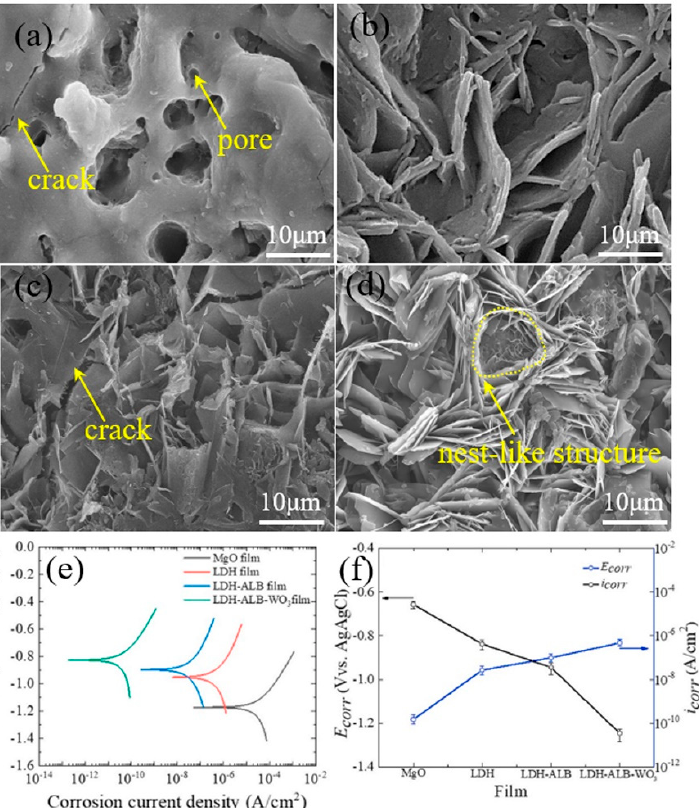
Figure 7. ( a – d ) SEM images showing the surface morphologies of MgO, LDH, LDH–ALB (albumin), and LDH–ALB–WO 3 films, respectively. ( e ) Potentiodynamic polarization (PDP) curves of the obtained films in a 3.5 wt.% NaCl solution. ( f ) The variation of E corr and i corr the obtained films in a 3.5 wt.% NaCl solution. Reprinted with permission from ref. [94]. Copyright 2021 Elsevier.